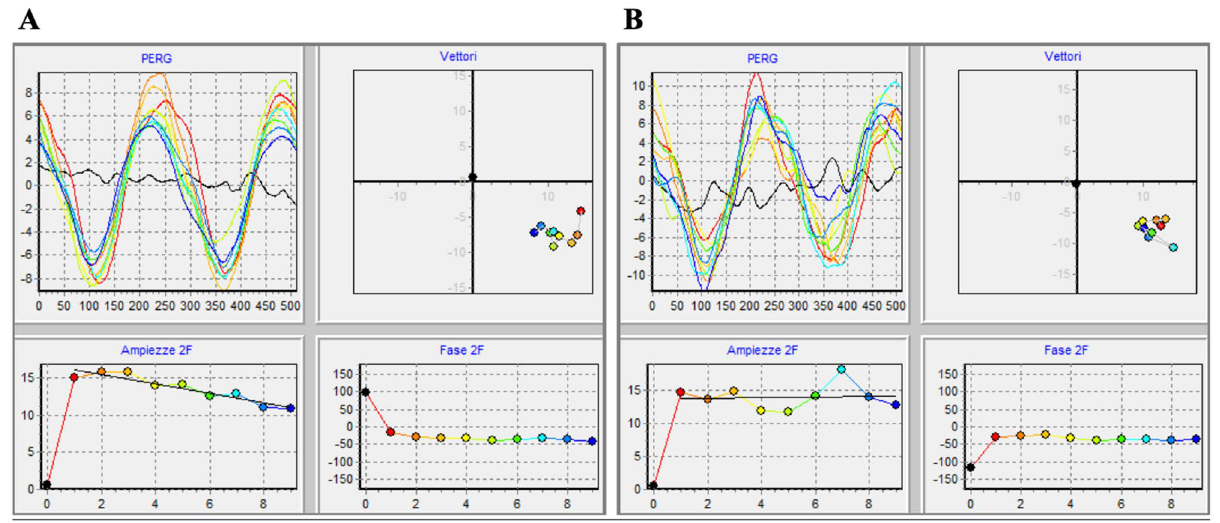
Figure 1. Representative examples of sequential PERGx samples recorded in two random subjects from control group ( A top left panel) and patient group ( B top left panel). The black waveform represents the noise recorded during an initial 10-s presentation of a grey uniform background, whereas the 9 coloured superimposed waveforms correspond to the responses obtained by high-contrast reversing black-and-white gratings. Data represent successive averages of 60 epochs each (~ 10 s sampling time). Top right graphs show PERGx vector changes over the recording time in the control subject ( A top right panel) and the patient ( B top right panel), respectively. The bottom graphs display how the PERGx amplitude and phase of successive samples (filled coloured symbols) change over time in the control ( A ) and in the patient ( B ), respectively.